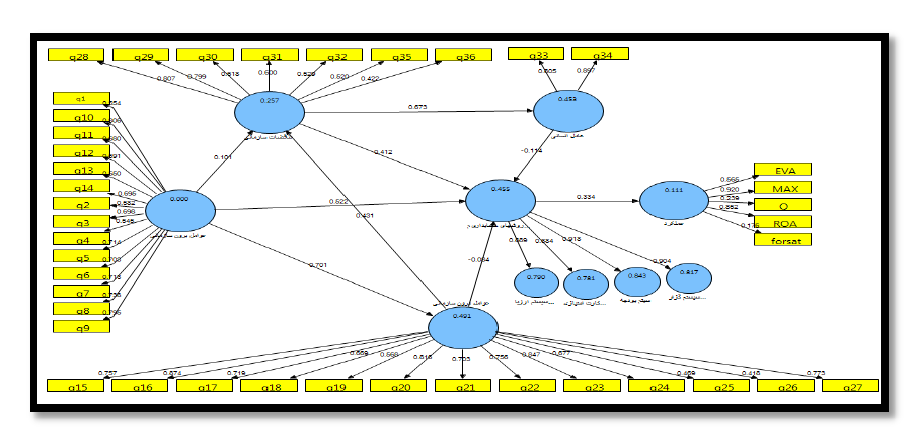
Figure 2. Model path coefficients